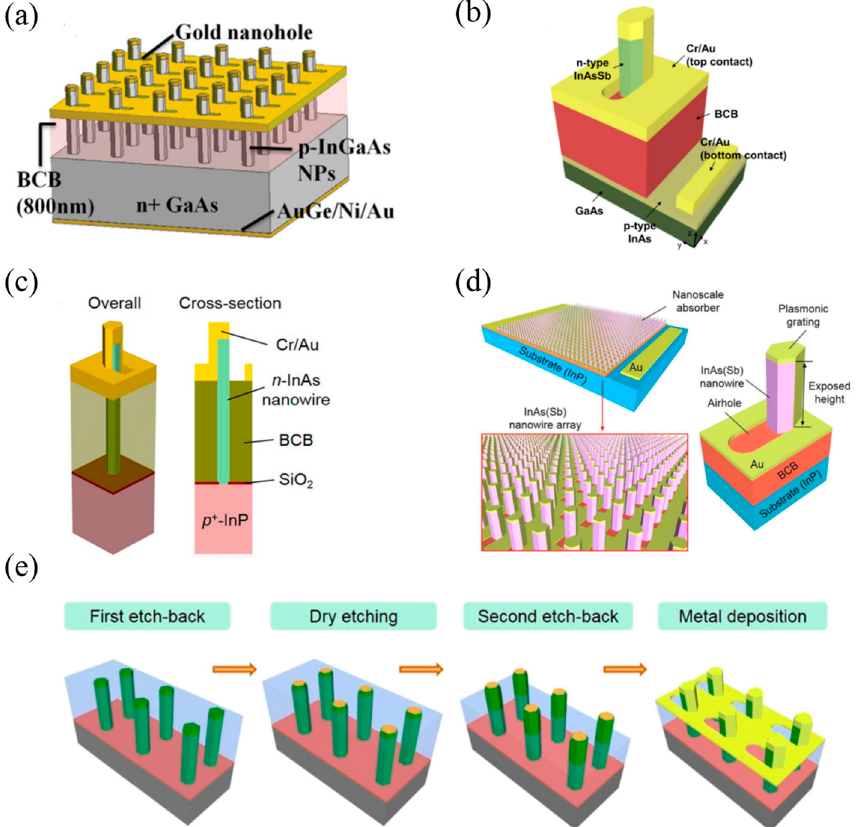
Figure 4. Structures and performance characterization of 1D materials-based infrared PDs with hole array structures. ( a ) Schematic of the NP PD array [38]. Copyright 2011, Nano Le tt ers. ( b ) Schematic